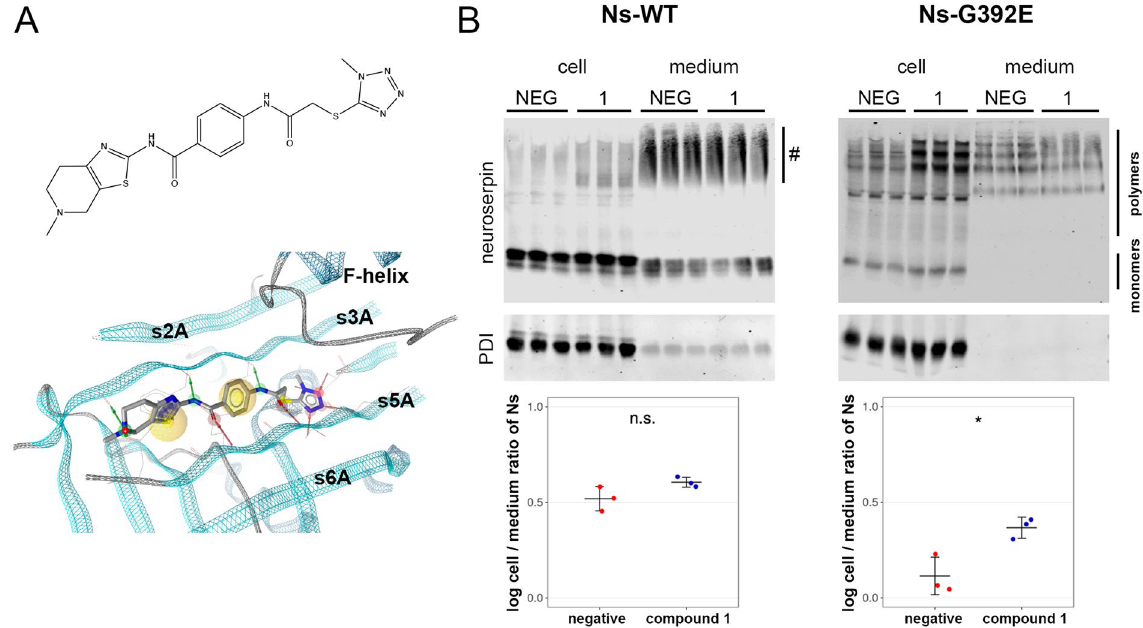
Figure 3. Secretion of G392E-neuroserpin can be pharmacologically regulated. ( A ) 2D structure (top) of compound 1 and visualization of its predicted binding mode (bottom). The protein backbone of neuroserpin is visualized as a ribbon. Green and red arrows indicate hydrogen bonds predicted to be formed between the ligand and the protein, and yellow spheres mark areas in the compound predicted to engage in hydrophobic interactions. Visualization with LigandScout 37 . ( B ) HEK-293 cells stably transfected with wild-type or G392E- neuroserpin were treated with the small organic compound 1 or solvent alone (NEG) for 18 h. Cell extracts (cell) and culture media (medium) were collected and analyzed by non-denaturing PAGE followed by